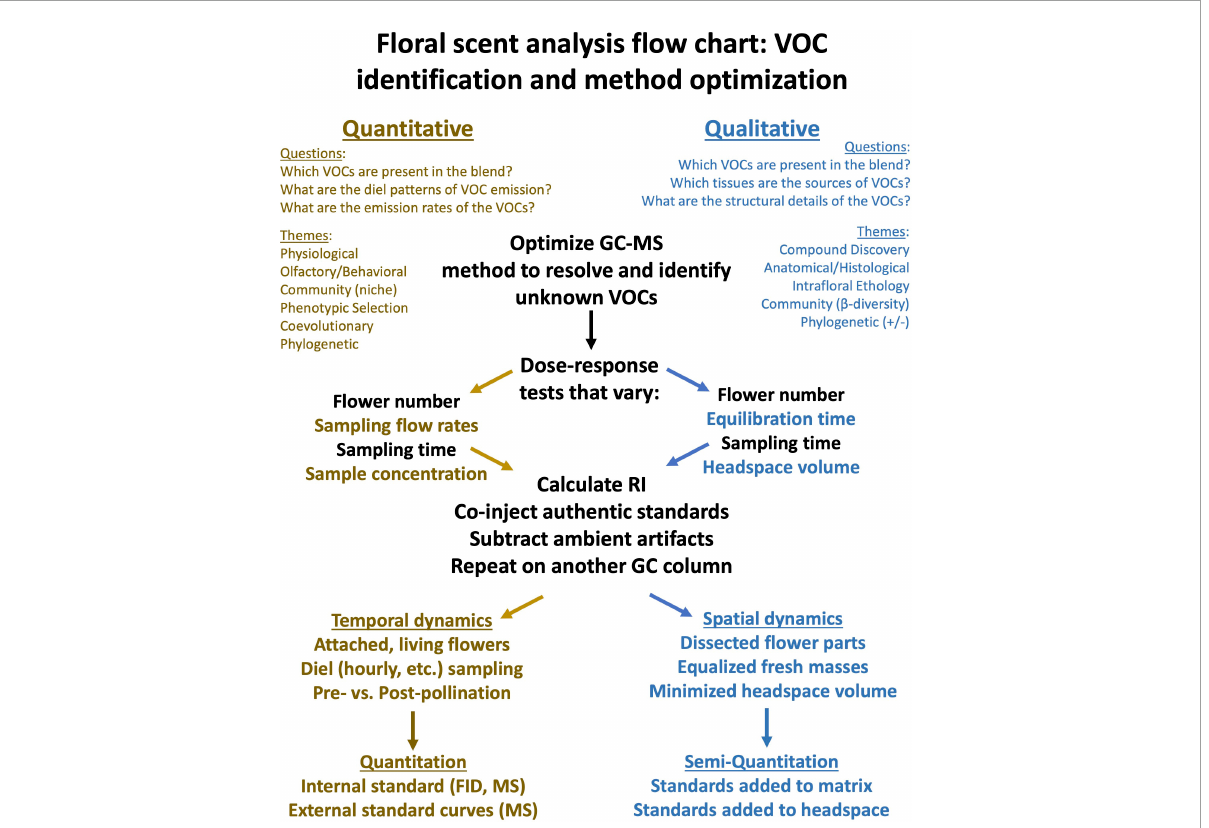
FIGURE1 A graphical illustration of how to develop and optimize methods for the analysis of floral VOCs. Brown text indicates questions and themes that are primarily quantitative in nature, whereas blue text is relevant for approaches that are often qualitative, and black text applies more generally. Note that these categories are not exclusive, but are meant to provide guidance to new investigators in this